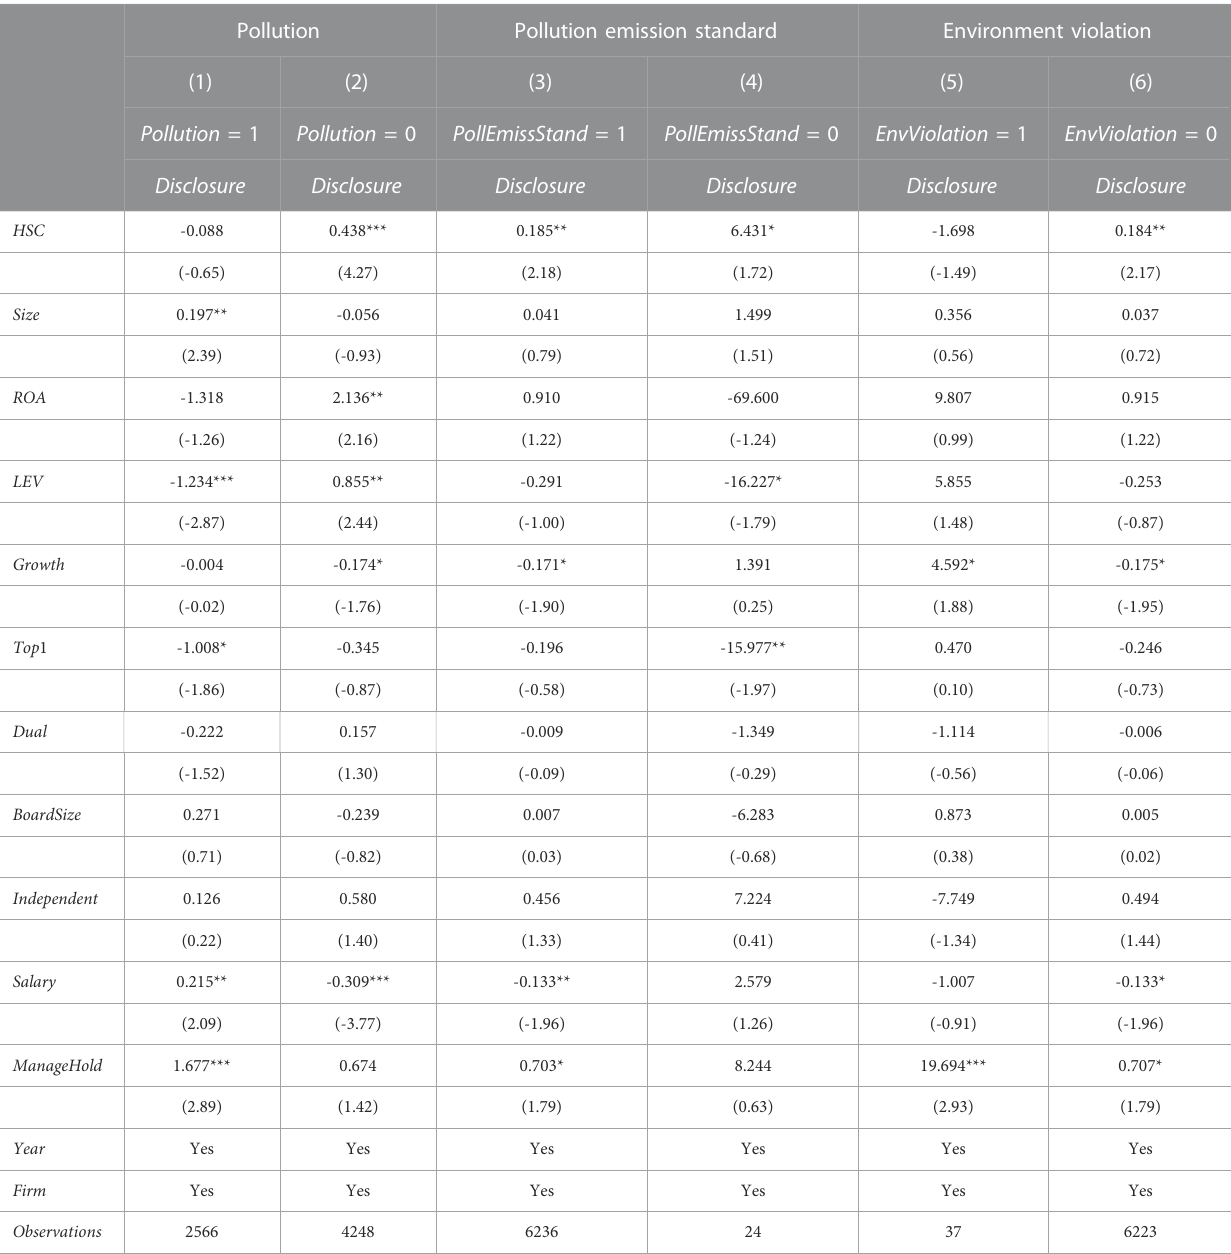
TABLE 7 Capital Market Liberalization and ESG Disclosure: by Environmental Performance: This table shows how the effect of capital market liberalization varies by environmental performance. We construct three dummy variables, Pollution , PollEmissStand , and EnvViolation , and split the sample fi rms into two groups based on the three variables, respectively. Pollution equals 1 if the fi rm belongs to a heavy pollution industry, and 0 otherwise. PollEmissStand equals 1 if the fi rm meets the pollution emission standard, and 0 otherwise. EnvViolation equals 1 if the fi rm is involved in environmental violation events, and 0 otherwise. Column 1 – 8shows the subgroup testing results where thedependent variable isthe fi rm-levelESGdisclosurescore( Disclosure ).Theexplanatory variables arethe dummy variable that represents the mainland-HK Stock Connect ( HSC ) and several control variables including Size , ROA , LEV , Growth , Top 1, Dual , BoardSize , Independent , Salary , and ManageHold . Refer to Table 1 for detailed variable de fi nition. t -statistics are reported in parentheses.***, ** and * denote signi fi cance levels at 1%, 5% and 10%,